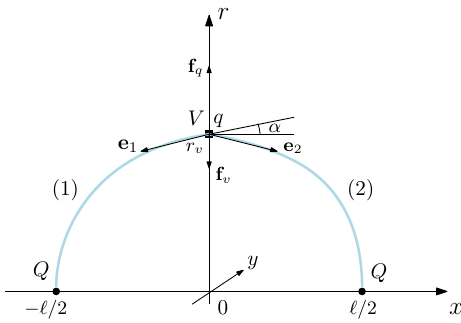
Figure 2 . A static string configuration at intermediate heavy quark separations. The light quark and vertex reside at the same point on the r -axis. The arrows indicate the forces applied at this